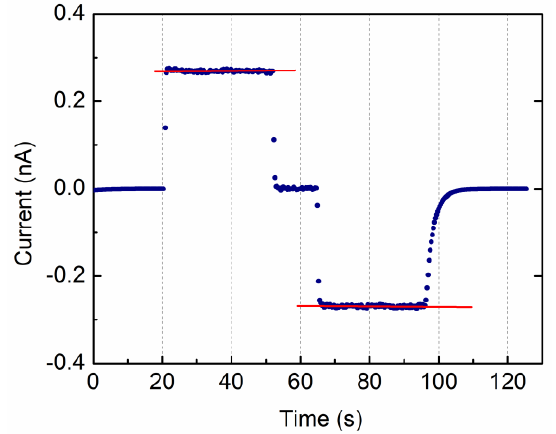
Figure 4. VRM applied to a slice of HD PTFE 2 mm thick. A 10 V/s voltage ramp is applied up to a flat top of 500 V; the output current (blue marks) shows the expected behavior for a real capacitor. Linear fits (red lines) to the top and bottom flat current intensity plateau are also shown.